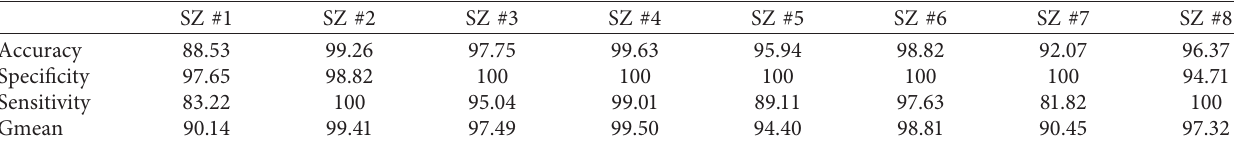
Table 8: Test Performance (%) of the cross-patient seizure detection system on patient #6.